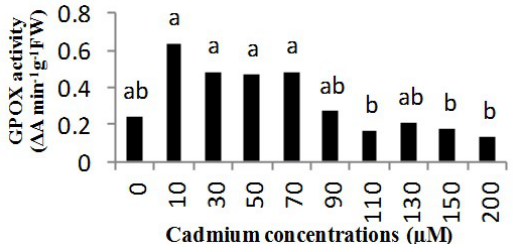
Fig. 11 . Effects of cadmium on guaiacol peroxidase activity of Brassica napus